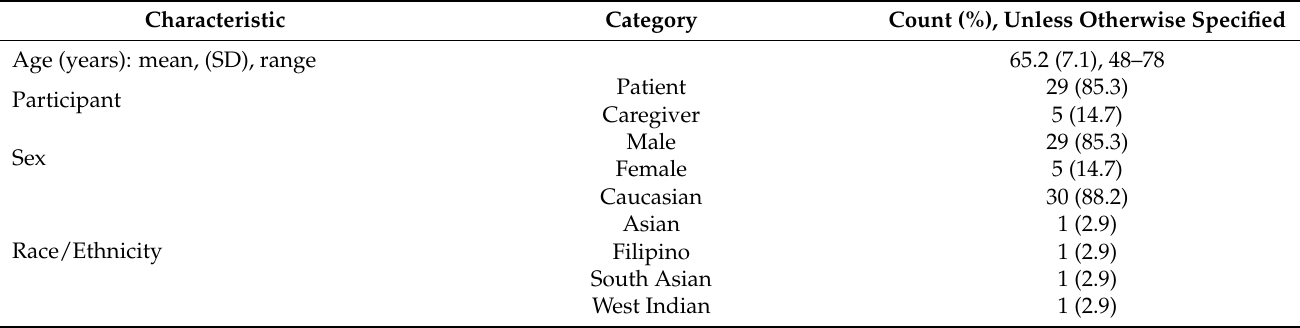
Table 1. Participant